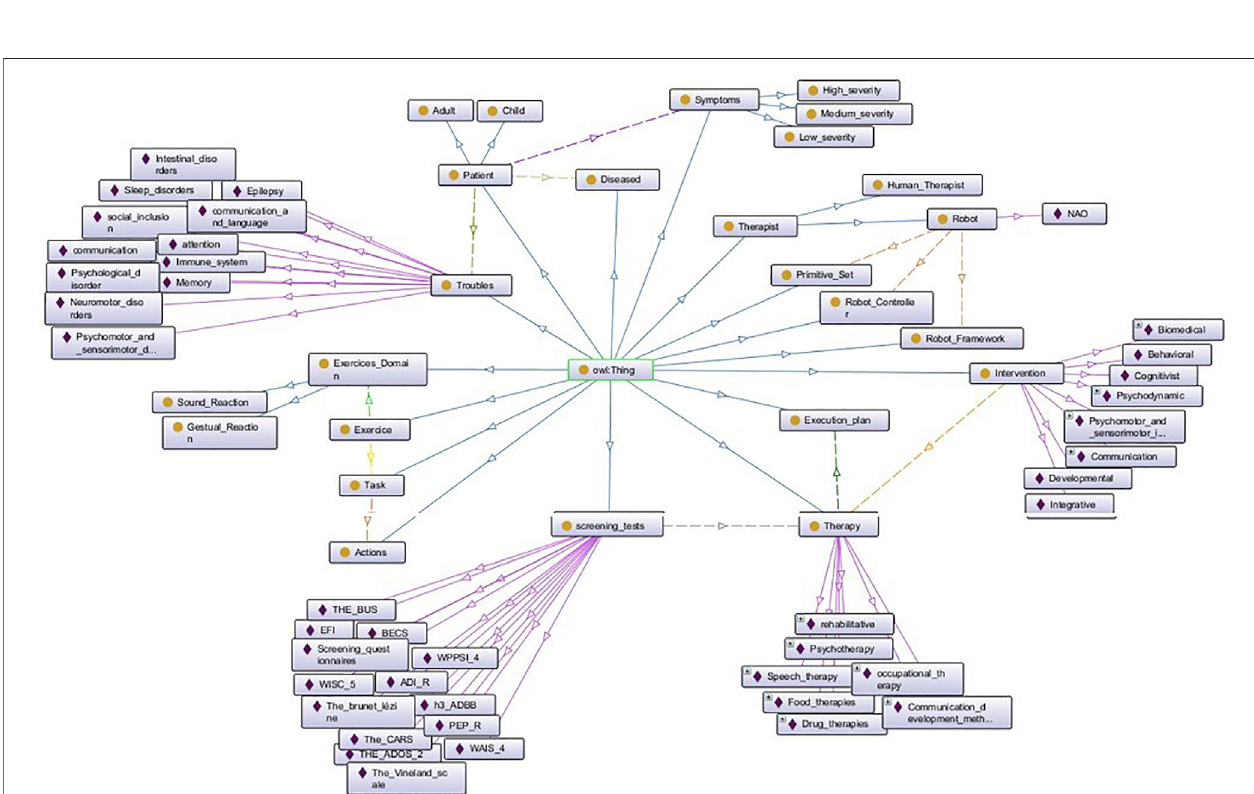
FIGURE 2 | The ontological model of a robot